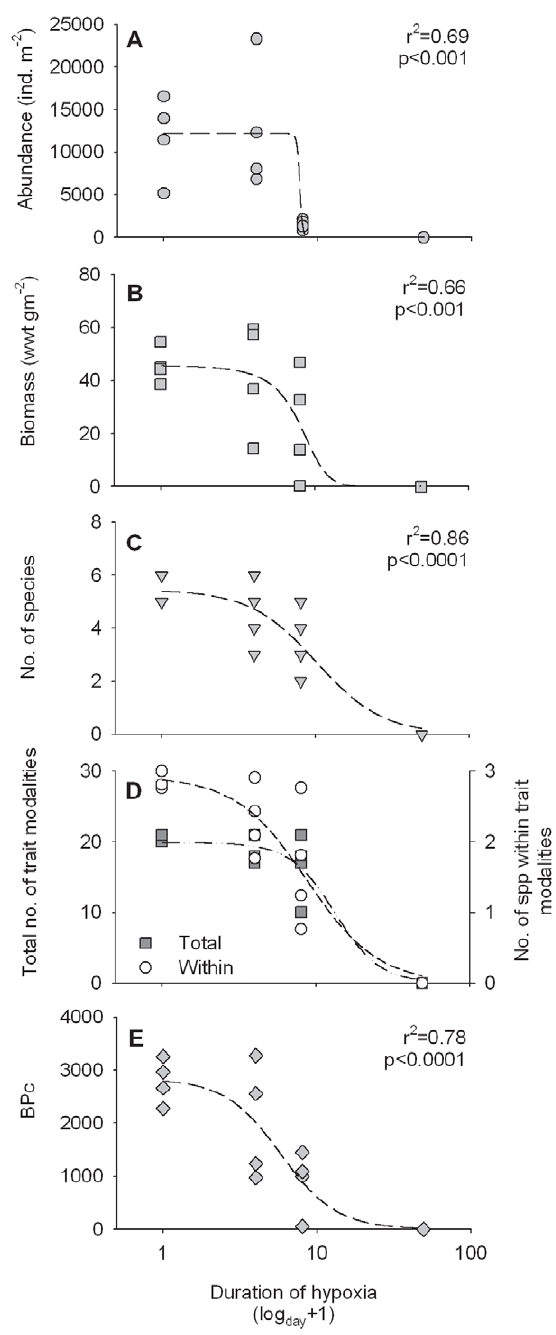
Figure 2. The effect of increasing duration of hypoxia on benthic parameters. (A) abundance (B) biomass (C) number of species (D) total number of trait modalities present (filled squares, primary y-axis, r 2= 0.93, p , 0.001) and the average number of species within trait modalities (white circles, secondary y-axis, r 2= 0.86, p , 0.001) and (E) the community bioturbation potential (BP c ). Mya arenaria is excluded from the biomass data. Non-linear regression curves were fitted to the plotted data (Table S2). For presentation, the x-axes are log (x + 1) transformed.